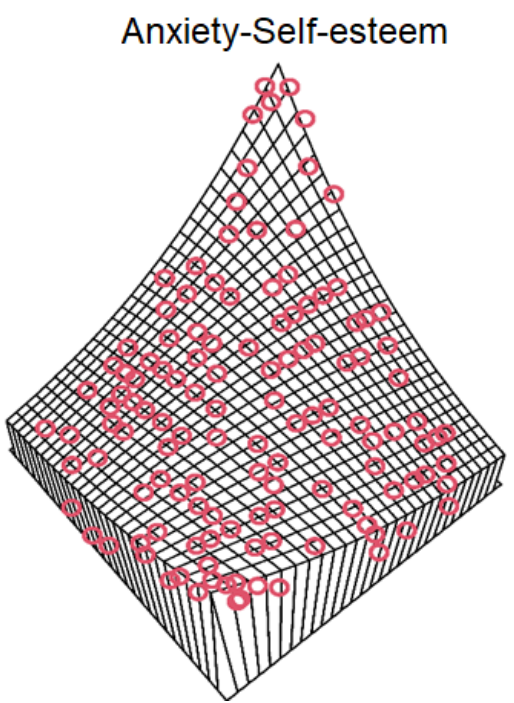
Figure 2. The perspective plot of the Frank copula and the scatter plot of the joint anxiety and self-esteem combinations.